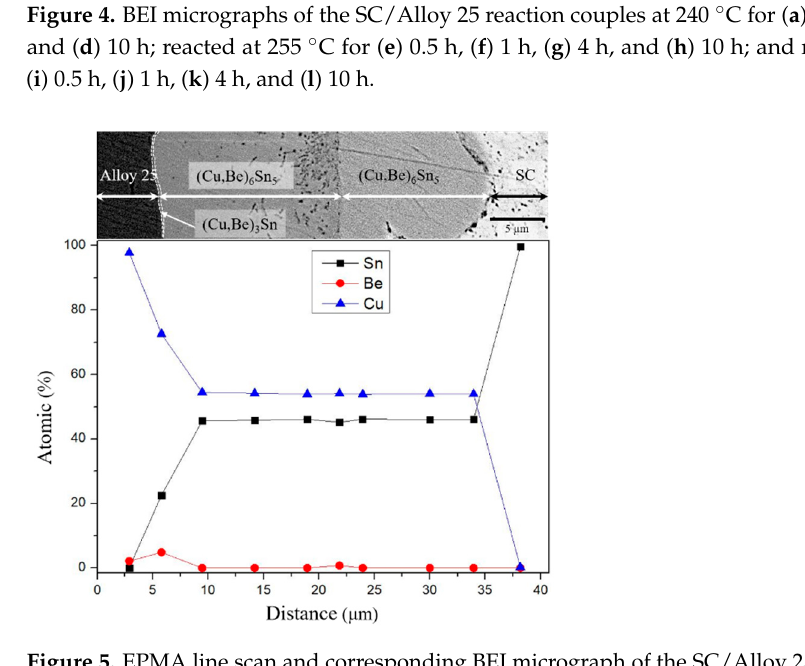
Figure 5. EPMA line scan and corresponding BEI micrograph of the SC/Alloy 25 reaction couple at a reaction temperature of 240 °C and reaction time of 1 h. reaction temperature of 240 ◦ C and reaction time of 1